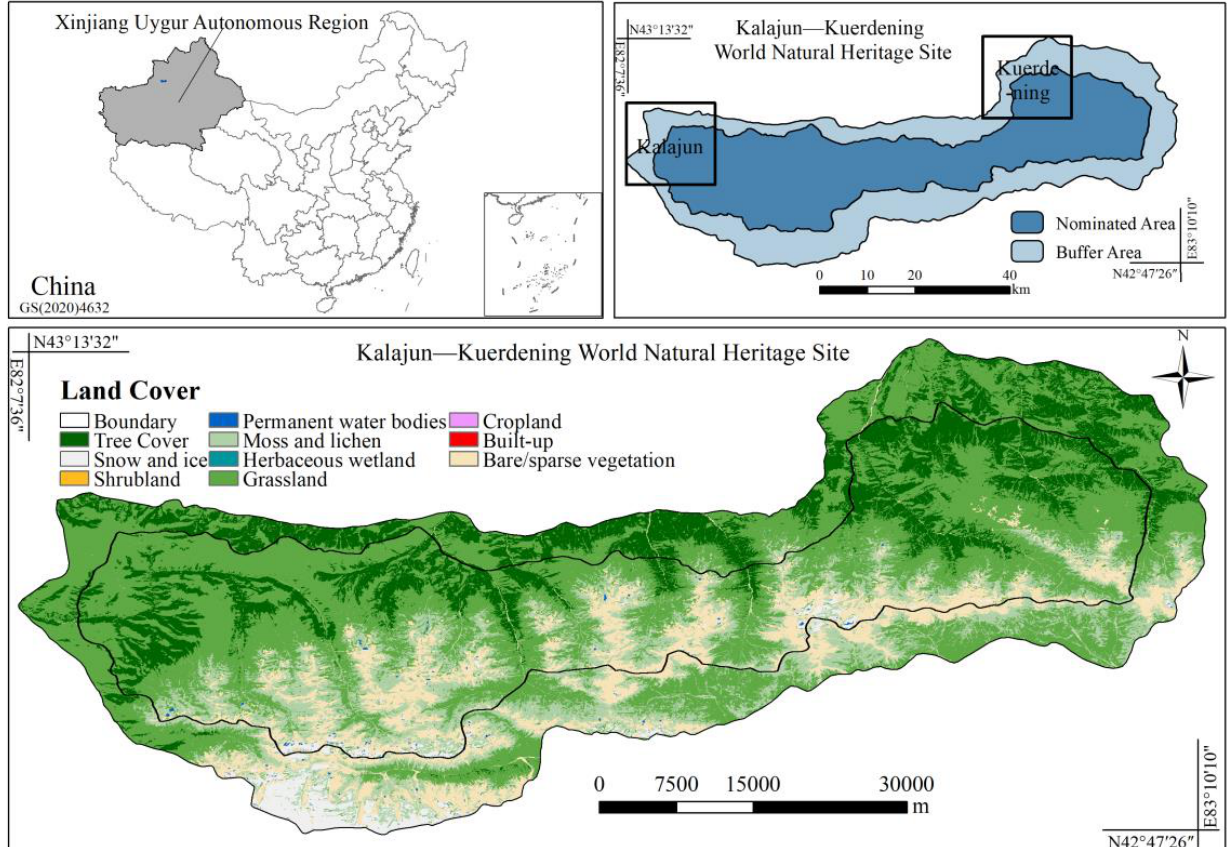
Figure 1. The location of the Kalajun–Kuerdening World Natural Heritage